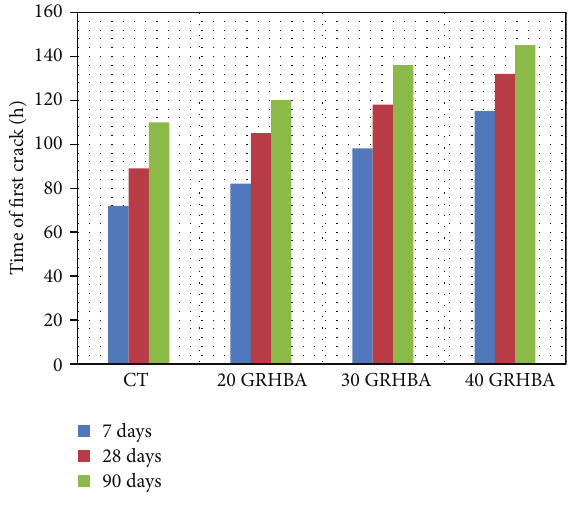
Figure 10: Time of first crack (h) of SCC.